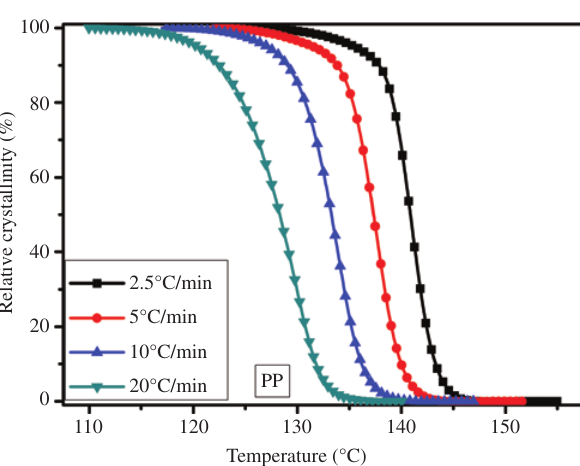
Figure 2 Plots of relative crystallinity percentage versus tempera- ture for